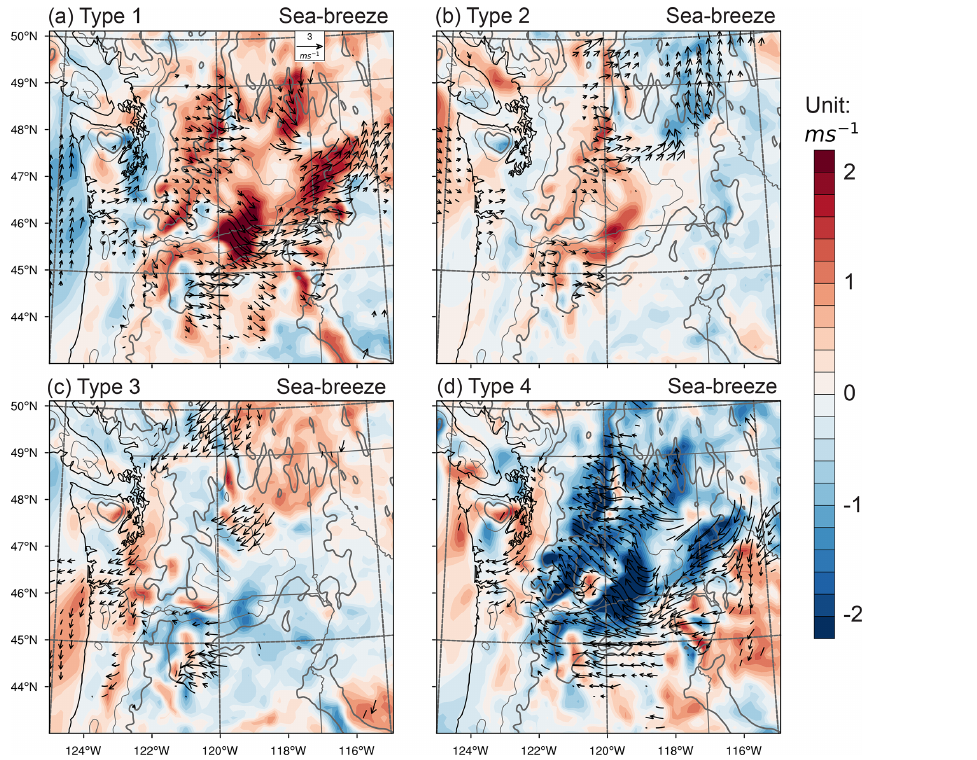
Figure 5. Turbine-height wind speed differences from the ensemble mean of each SOM type for the sea-breeze case at 29h. Wind vectors are shown when either the zonal or meridional wind anomalies are significant at the 0.05 level. Colors indicate the wind speed anomaly. Gray lines indicate terrain elevation of 500 (thin) and 1000m